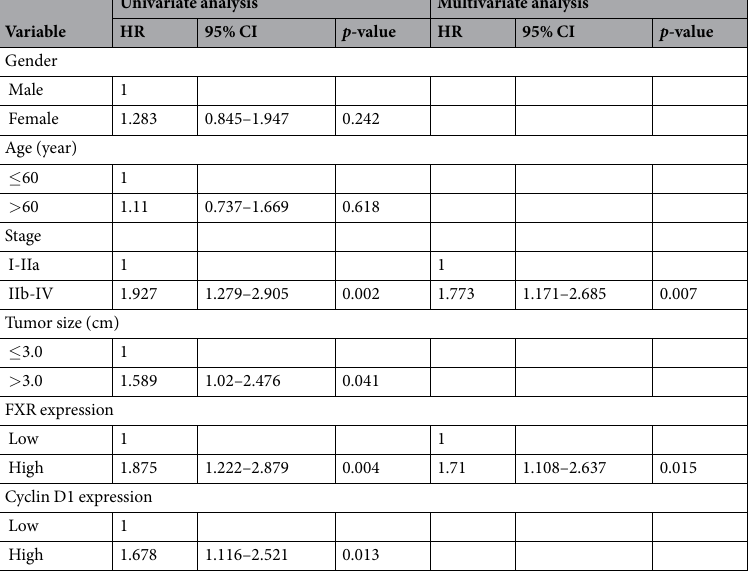
Table 3. Univariate and multivariate Cox regression analysis for OS in